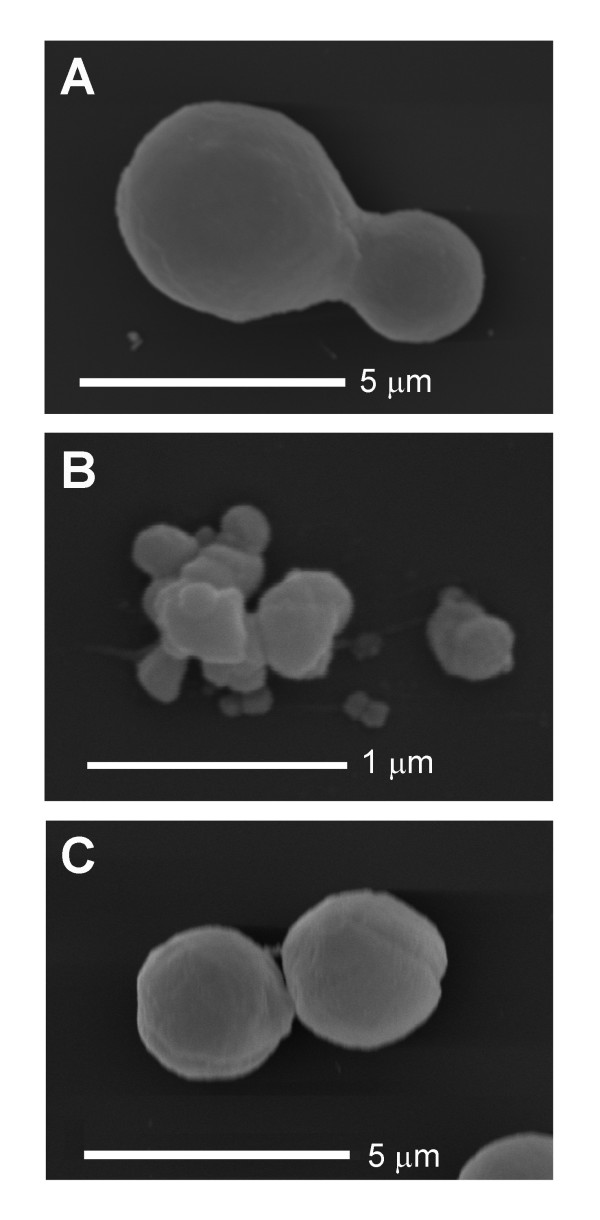
Representative scanning electron microscopy of particles collected after treatment with enzymes, denaturant, and hot acid from W. dermatitidis strains A] 8656, B] wdpks1Δ-1, and C] wdpks1Δ-1-501 grown for 10 days in YPD medium at 37°C.